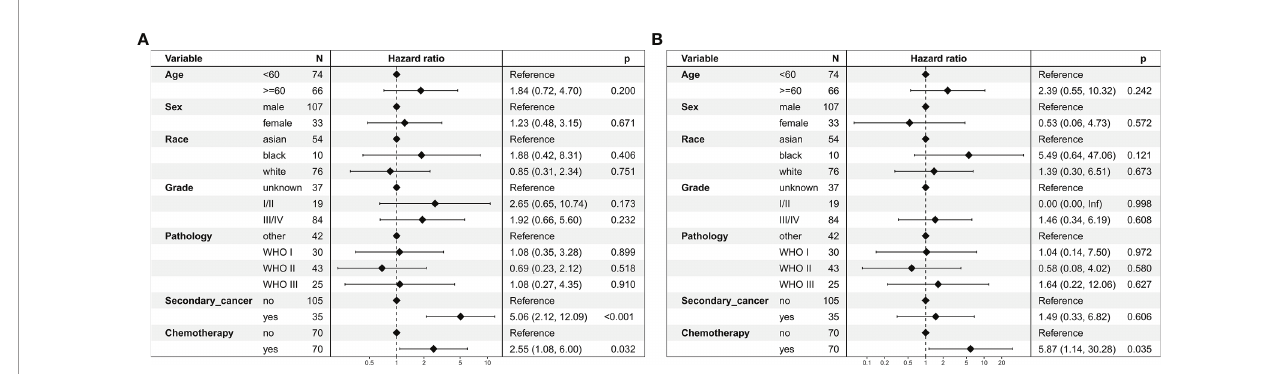
FIGURE 6 | Multivariate regression analysis of prognostic factors for patients with stage I nasopharyngeal carcinoma in the propensity-matched cohort. (A) Overall survival. (B) Cancer-speci fi